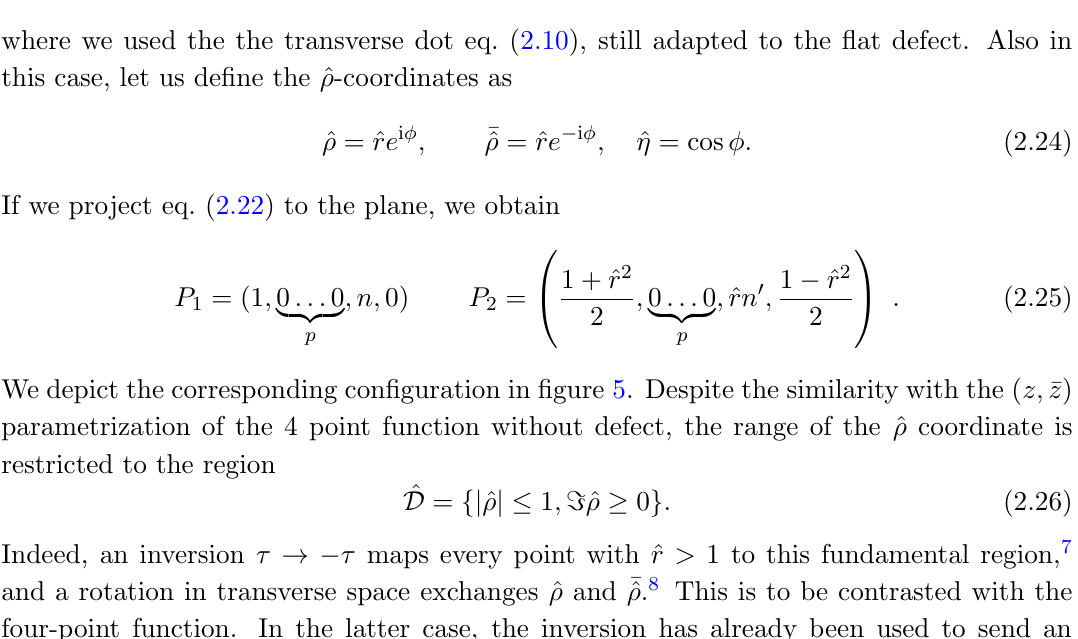
Figure 5 . The con(cid:12)guration corresponding to eq. (2.25). The defect is (cid:13)at and orthogonal to the plane drawn in the (cid:12)gure, and crosses it at the position marked by the red dot. The operator sits at unit radius, while the position of is parametrized by the complex coordinates (^ (cid:26); (cid:22)^ (cid:26) ). The O 2 fundamental domain ^ is highlighted in D